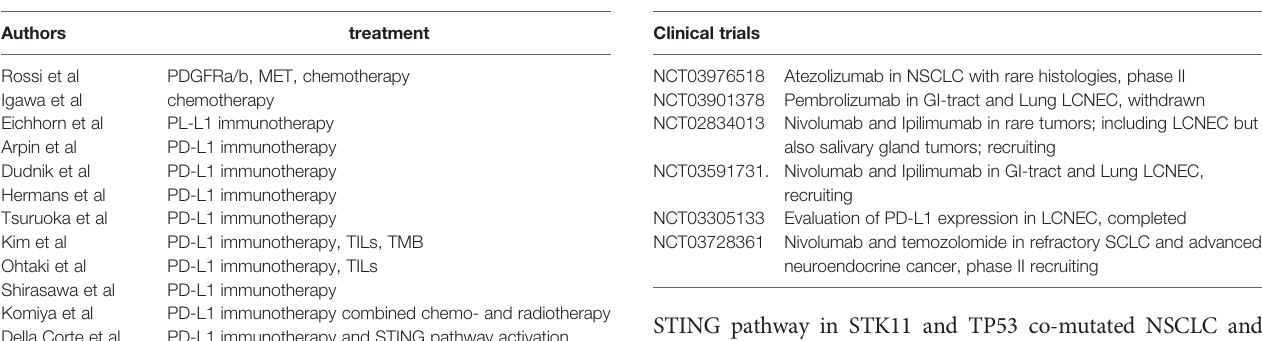
TABLE 2 | Ongoing clinical trials focusing on immunotherapy (chemotherapy trials are not included here).